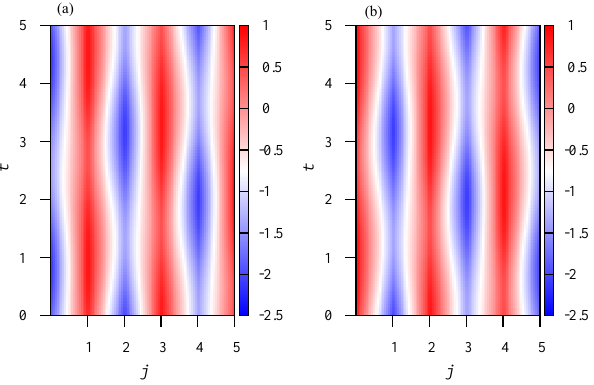
Figure 5. As Fig. 1, but for two periodic attractors for n = 6 and F = − 3 . 6. These attractors are born at Hopf bifurcations of the equilibria x P, 1 (a) and x P, 2 (b) at F = − 7 / 2. Note that the waves do not travel “eastward” or “westward”. The pitchfork bifurcation changed the mean flow which in turn changes the propagation of the